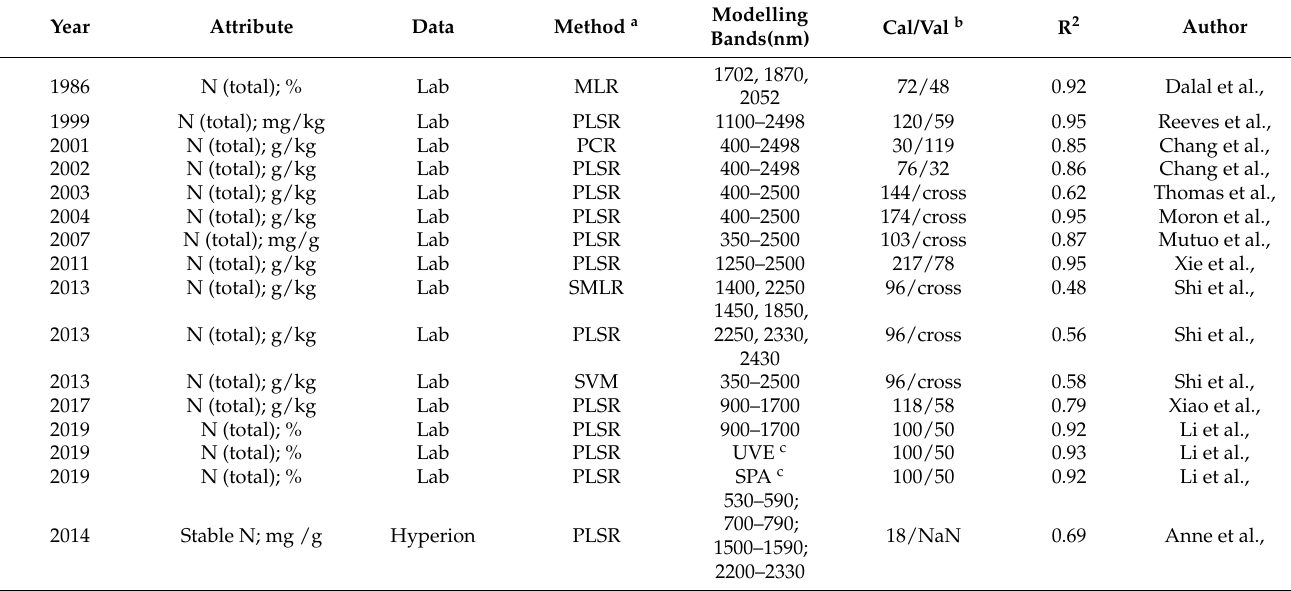
Table A1. A review of the studies comparing quantitative analysis of soil N content using calibration and validation modelling method by the ground spectra and remote sensing